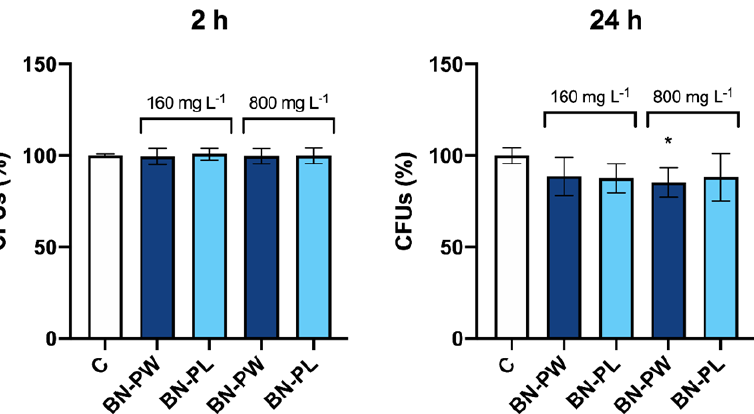
Figure 8. Determination of S. cerevisiae cells colony forming units (CFUs) after exposure to 160 and 800 mg/L of BN-PW and BN-PL, during 2 and 24 h. “C” corresponds to non-exposed cells. Two independent experiments, employing three technical replicates per exposure condition tested, were performed. One-way ANOVA followed by the Dunnett post hoc test was done to compare every mean with that of the control, and considered significant at p ≤ 0.05. * p ≤